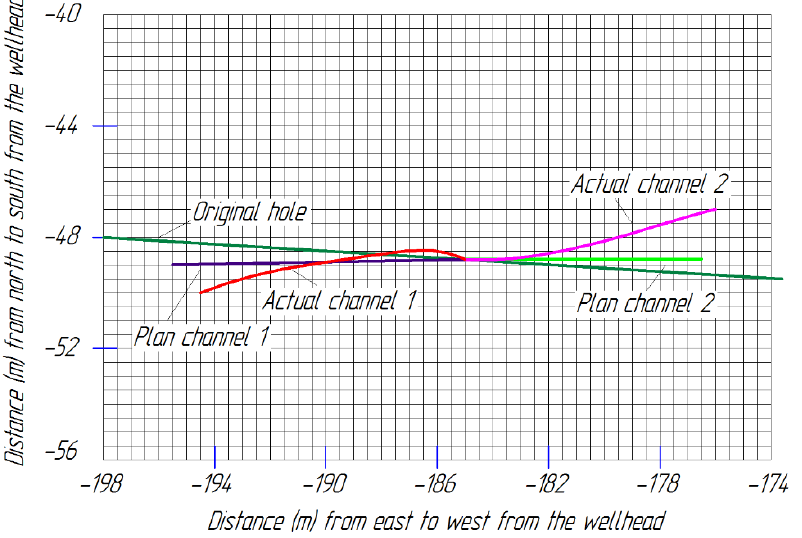
Figure 8. Drilled channel trajectories (top view) based on data from the gyroscope, “TWIN GYRO” (No. 1 in red), and the inclinometer, “KVARTS-36” (No. 2 in purple).